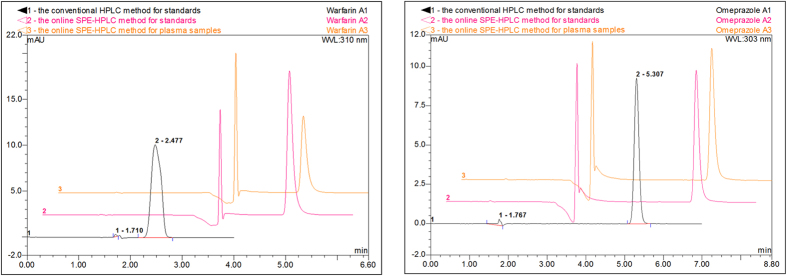
The comparison charts of warfarin sodium (left) and omeprazole (right) (1-interference peak, 2-drugs peak).